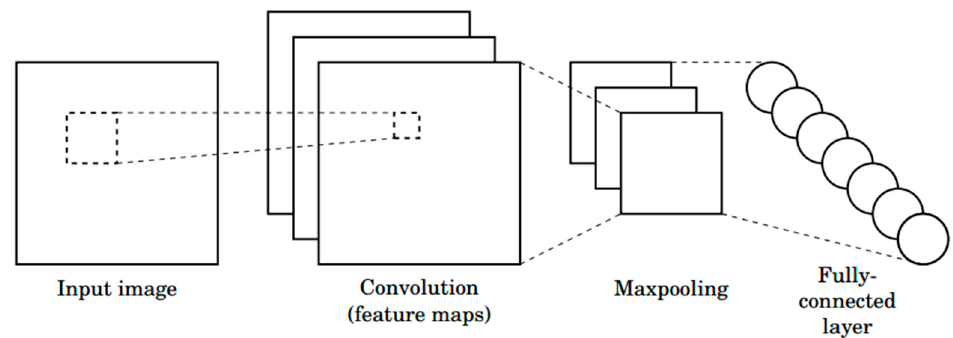
Figure 1. Typical structure of the convolutional neural network (CNN).